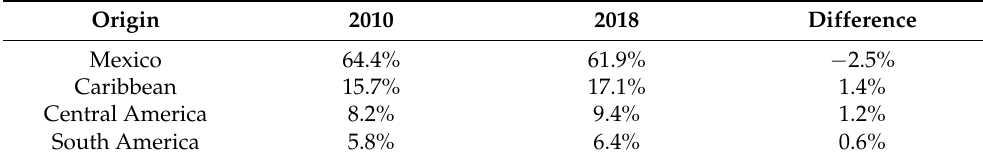
Table 1. Hispanic population origins in the United States (adapted from Gonz á lez-Barrera et al. 2020). Origin 2010 2018 Difference Mexico 64.4% 61.9% − 2.5% Caribbean 15.7% 17.1% 1.4% Central America 8.2% 9.4% 1.2% South America 5.8% 6.4%